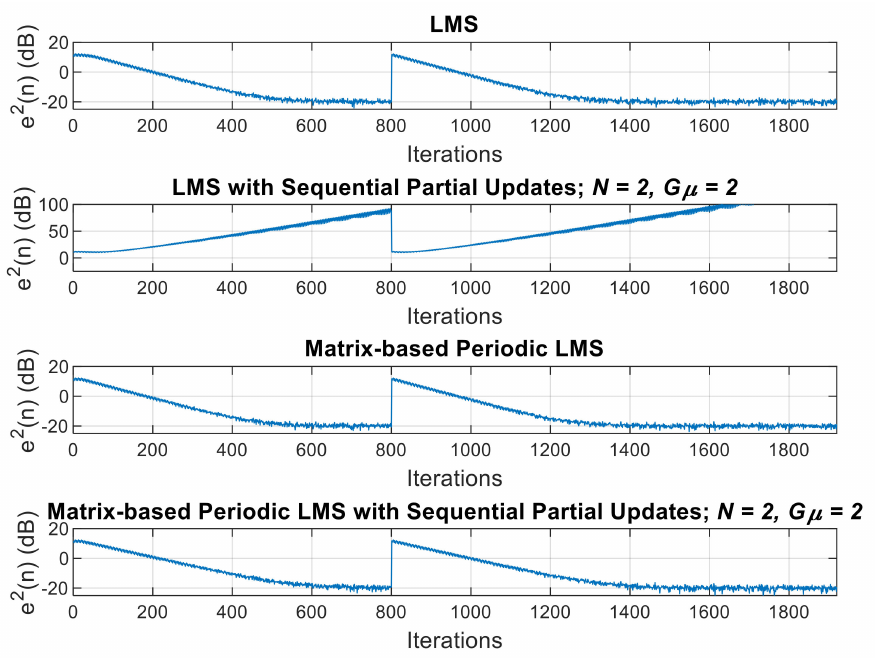
Figure 11. Learning curves comparison. Version 1 of the experiment: desired signal d 1 ( n ) and reference signal x 1 ( n ) . ( a ) LMS, ( b ) LMS with Seq PU; N = 2 and G µ = 2, ( c ) P-LMS, ( d ) P-LMS with Seq. PU; N = 2 and G µ = 2. Average of 50 runs. The performance measure used is the instantaneous squared error in logarithmic scale